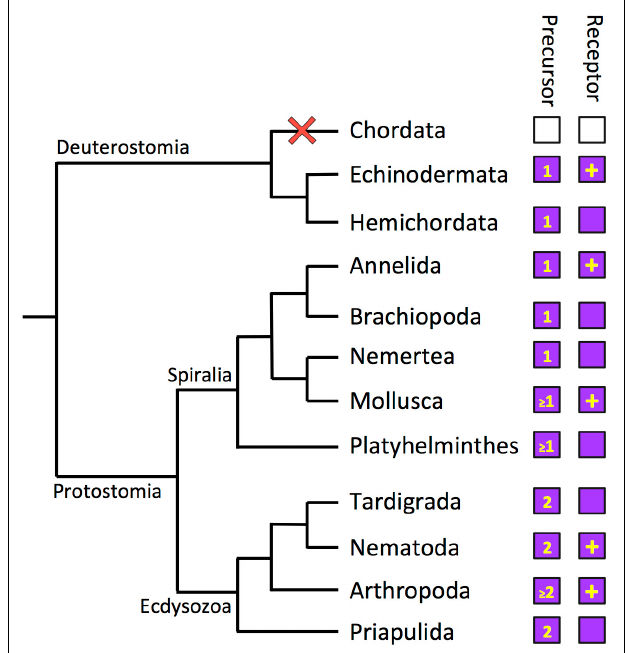
FIGURE 3 | Phylogenetic diagram showing the occurrence of luqin-type neuropeptide signaling in the Bilateria. The phylogenetic tree shows relationships of selected bilaterian phyla. The phyla in which luqin-type precursors and luqin-type receptors have been identified are labeled with purple-filled boxes. The number in the precursor box indicates how many luqin-type neuropeptides are known or predicted to be derived from the precursor protein. The inclusion of a plus symbol in the receptor boxes indicates that the peptide ligand(s) that activates the receptor has been determined experimentally. Note the loss of the luqin-type signaling system in the chordate lineage, which is signified by the red cross and the white-filled boxes. Note that Xenacoelomorpha are not included in this diagram because of the controversy regarding the phylogenetic position of this phylum. However, as discussed in this review, luqin-type receptors have been identified in xenacoelomorphs but the precursors of peptides that act as ligands for these receptors have yet to be identified. The cladogram depicting bilaterian relationships is based on a recent phylogenetic study reported by Laumer et al.